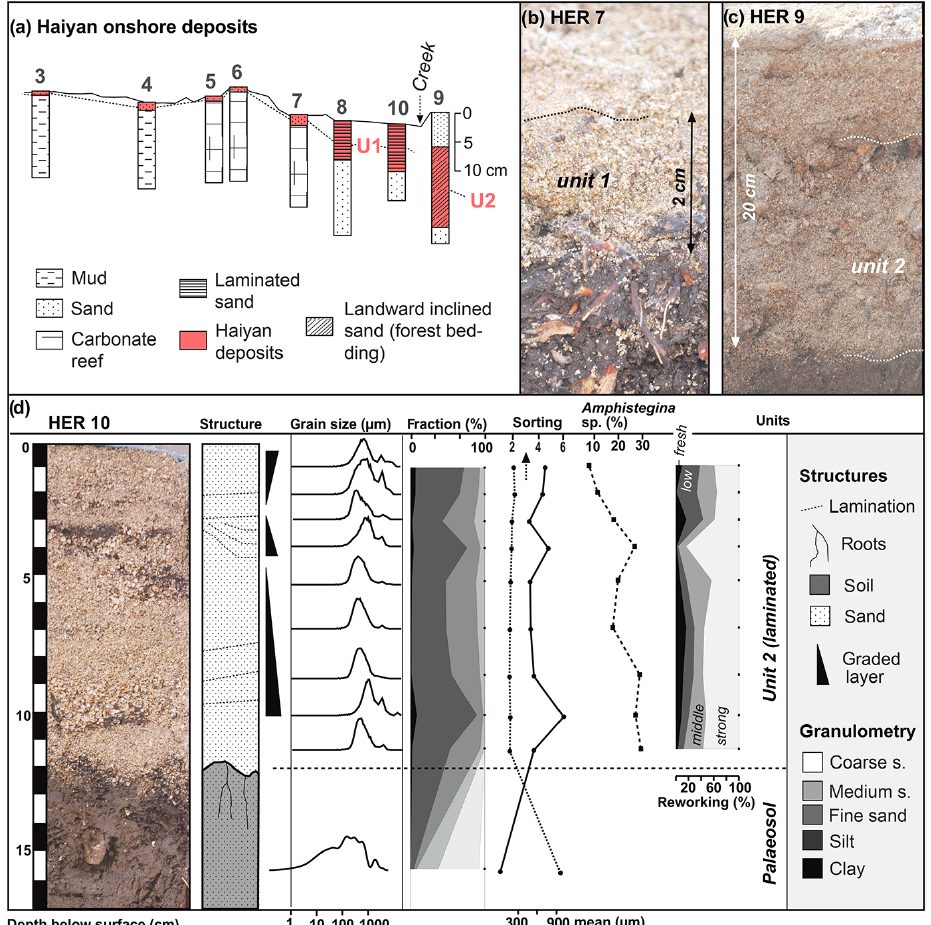
Figure 4. Onshore deposits of Typhoon Haiyan at site HER. (a) Landward transect illustrating the succession of typhoon deposits (see Fig. 2 for location). The basal unit 1 (U1) continuously thins landwards, while unit 2 (U2) is restricted to the proximal part of the coastal plain (HER 9). (b) The 2cm thick unit 1 at HER 7 (photography: February 2014). (c) The 20cm thick unit 2 at HER 9 (photography: February 2014). (d) Sedimentary characteristics of HER 10. A 12cm thick typhoon layer can clearly be separated from the palaeosol. The storm layer reveals repeated normally and inversely graded laminae, in which the amount of strongly reworked foraminifera is highest within the coarse basal